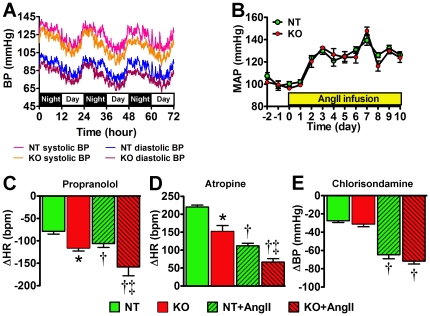
Normal blood pressure and increased autonomic dysfunction in young ACE2−/y mice.Baseline blood pressure traces from young non-transgenic (NT) and ACE2−/y (KO) mice over 3 days recording show no differences between genotypes (A). Mean arterial pressure (MAP) was similarly increased in both NT and KO mice during AngII infusion (B). KO mice exhibited enhanced bradycardia to propranolol (C; *P<0.05 vs. NT; n = 8) and reduced tachycardia following atropine (D; *P<0.05 vs. NT; n = 8). AngII infusion significantly increased sympathetic drive (C) and reduced vagal tone (D) in both NT and KO (†P<0.05 vs. baseline, n = 8). Autonomic dysfunction remained more pronounced in KO compared to NT following AngII infusion. (C,D; ‡P<0.05 vs. NT+AngII). Changes in BP following ganglionic blockade, an index of vascular sympathetic drive, were not different between NT and KO on baseline or following AngII infusion (E; P>0.05).